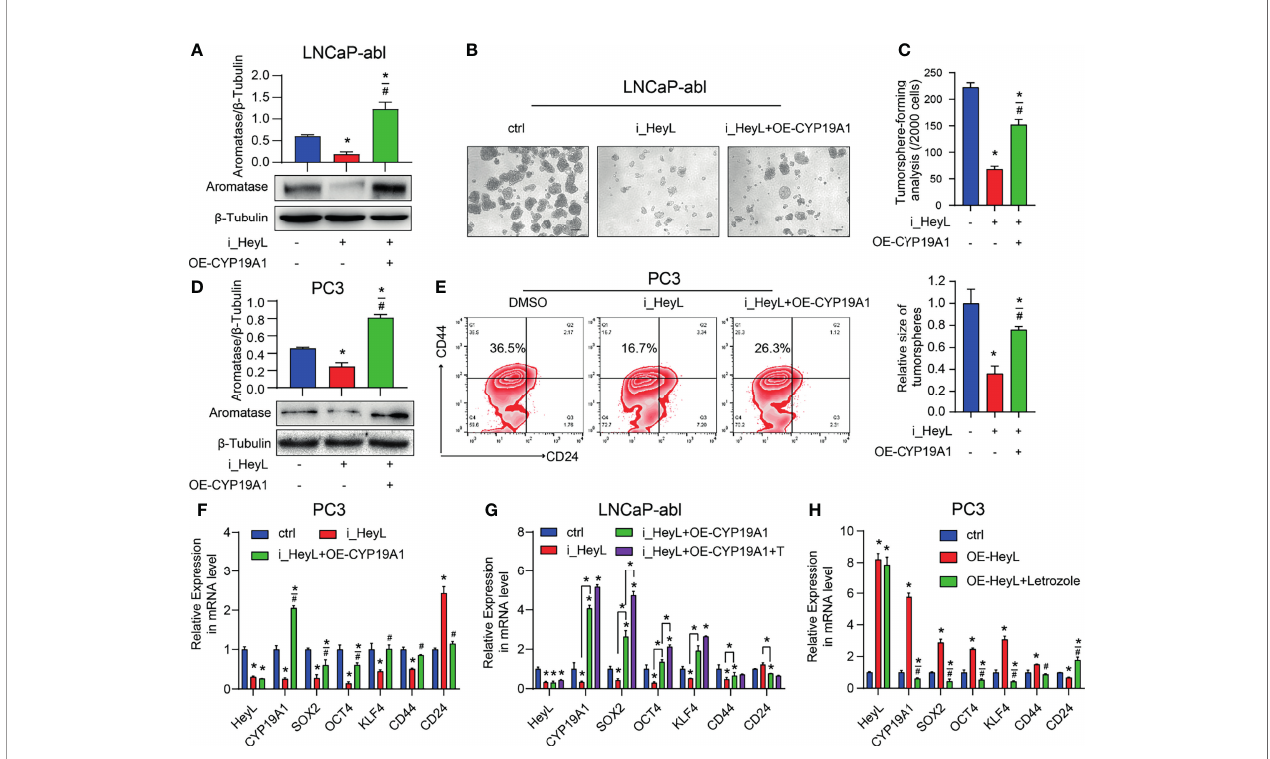
FIGURE 4 | HeyL regulates PCSC properties by upregulating CYP19A1 expression. (A – C) Tumorsphere-forming ability of LNCaP-abl cells treated as indicated. The protein levels of aromatase, representative micrographs, and quantitative results (one-way ANOVA) are shown in (A) , (B) , and (C) , respectively. Scale bar: 100 m m. (D, E) Flow cytometry analysis of the CD44 + /CD24 − subpopulation in PC3 cells treated as indicated. (D) Protein levels of aromatase. (E) The results of fl ow cytometry analysis. (F – H) mRNA levels of CD44 and the indicated stemness-associated genes in PC3 (F, G) and LNCaP-abl (H) cells treated as indicated (one-way ANOVA). The data are presented as the mean ± SD values (n=3). * p < 0.05 vs. ctrl. # p < 0.05 vs. i_HeyL or